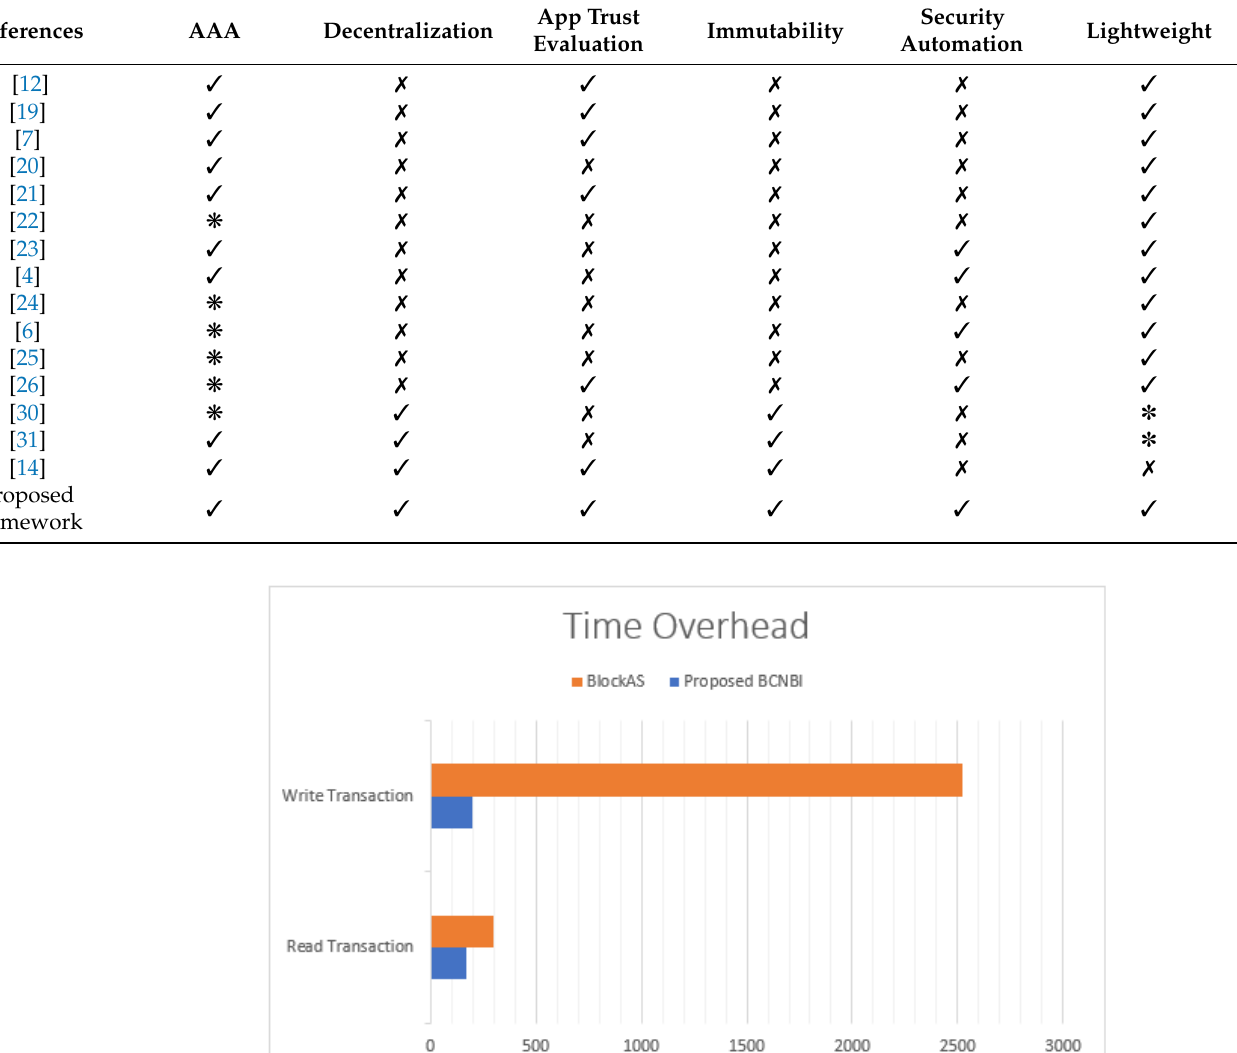
Table 2. Comparison of existing approaches for securing the northbound interface of the SDN controller. (cid:51) , fully achieved; (cid:107) , partially achieved; (cid:55) , not achieved.